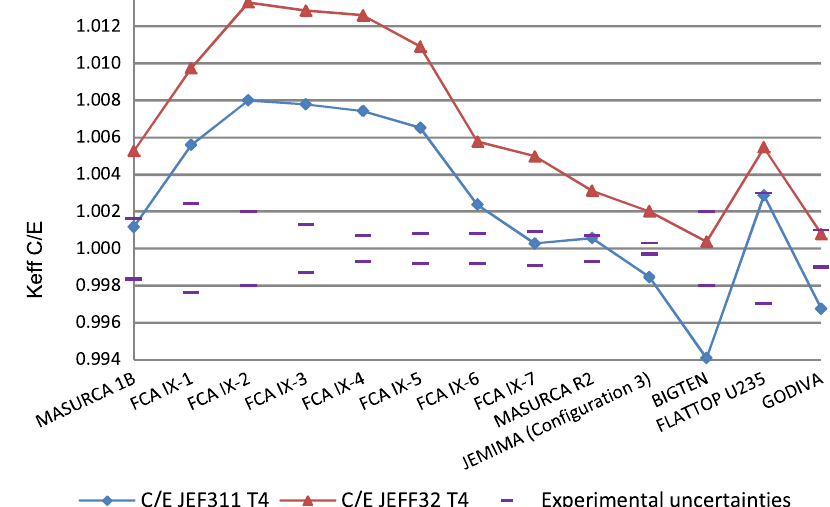
Fig. 1. Critical mass C/Es compared with experimental uncertainties for Uranium con fi gurations (using JEFF libraries).